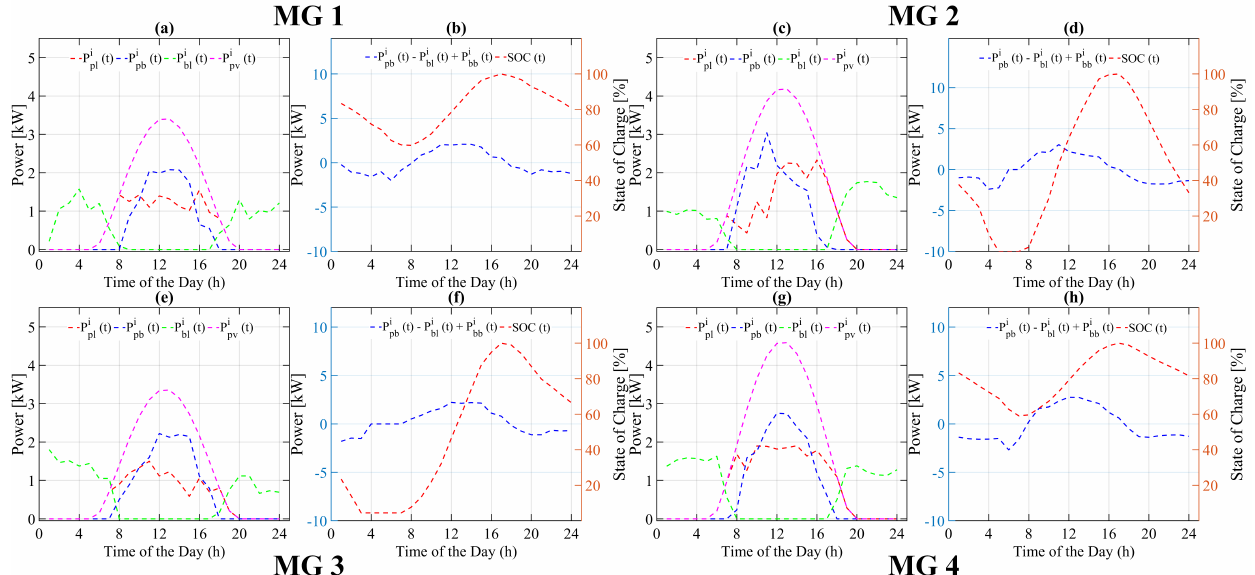
Figure 6. Power flow of various system variables of each microgrid using heuristic state flow based energy management strategy for case A. ( a , c , e , g ) Power flow of PV, battery and Load, ( b , d , f , h ) Battery charging/discharging and state of charge.